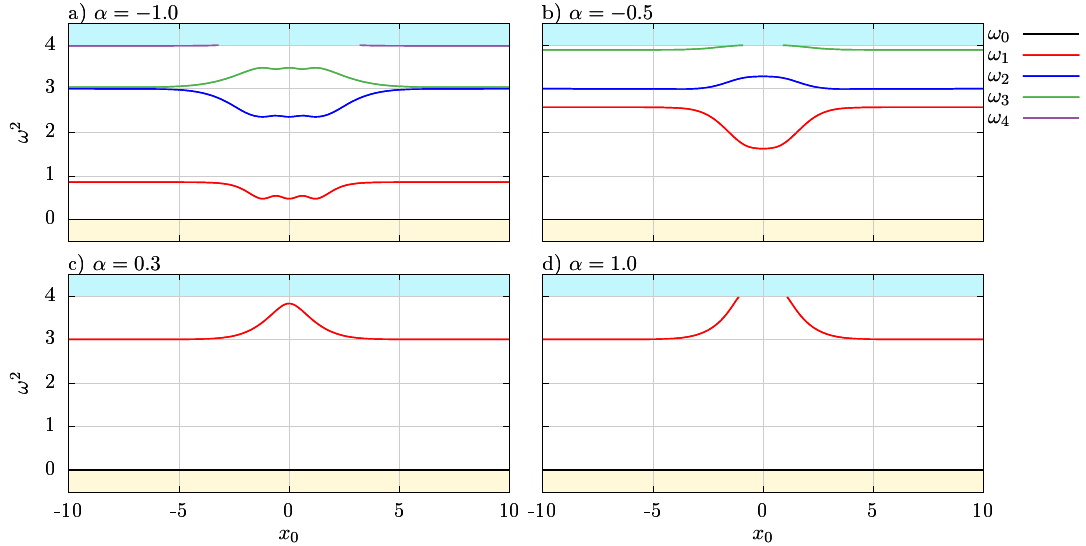
Figure 12 . Spectral structure of the BPS solution for di(cid:11)erent values of (cid:11) , as a function of the topological zero of the